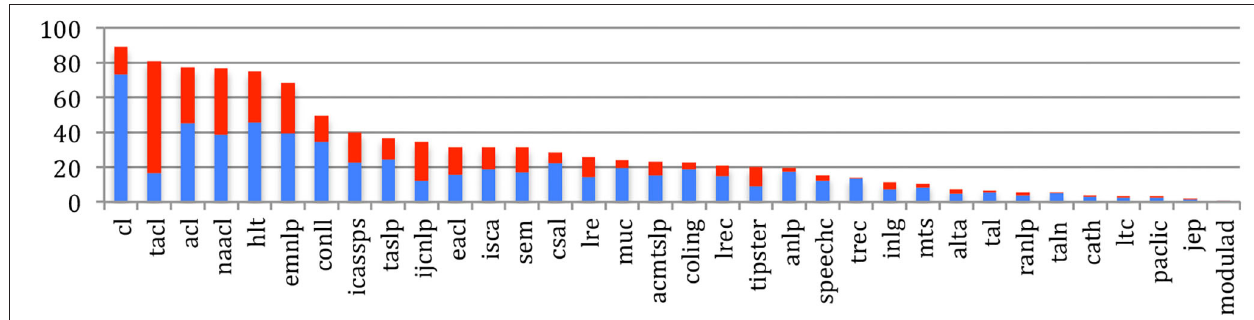
FIGURE 22 | Mean Degree of authors being cited for the 34 sources in 2015 (blue) and 2020 (red).